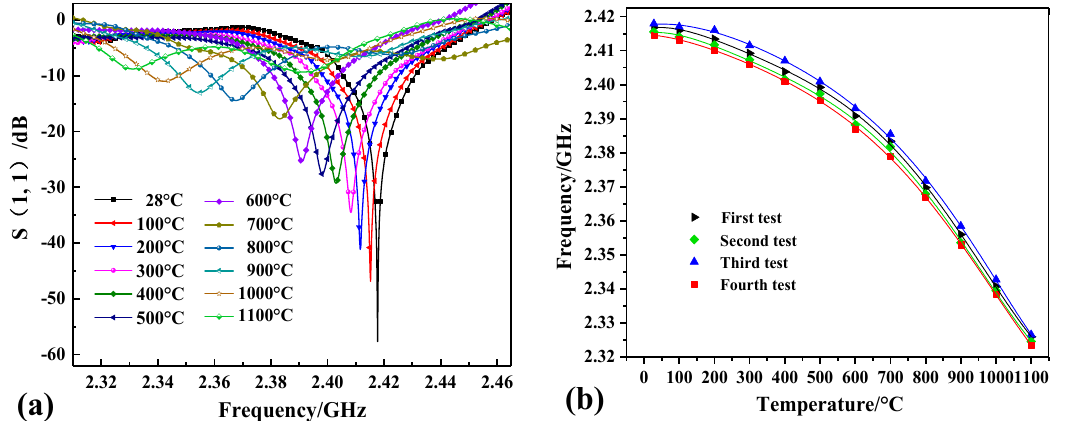
Figure 8. ( a ) S (1, 1) spectra of the sensor when the temperature is increased from 28 to 1100 °C; ( b ) Repeatability testing of the sensor